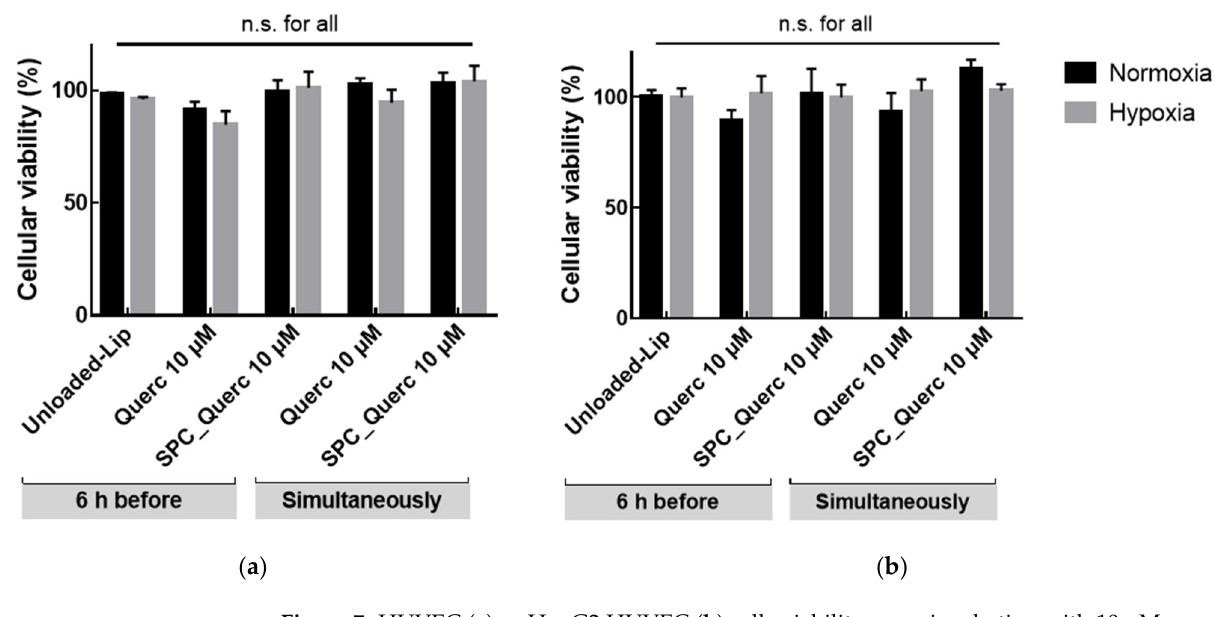
Figure 7. HUVEC ( a ) or HepG2:HUVEC ( b ) cells viability upon incubation with 10 µM quercetin. Viability was evaluated either with liposomal or free quercetin, under hypoxia or normoxia conditions, in the presence of complete medium. Unloaded-liposomes (Unloaded-Lip) were used as control. Results presented as mean ± SD ( n = 3). n.s., statistically non-significant (free vs. liposomal quercetin, at the same time of addition).